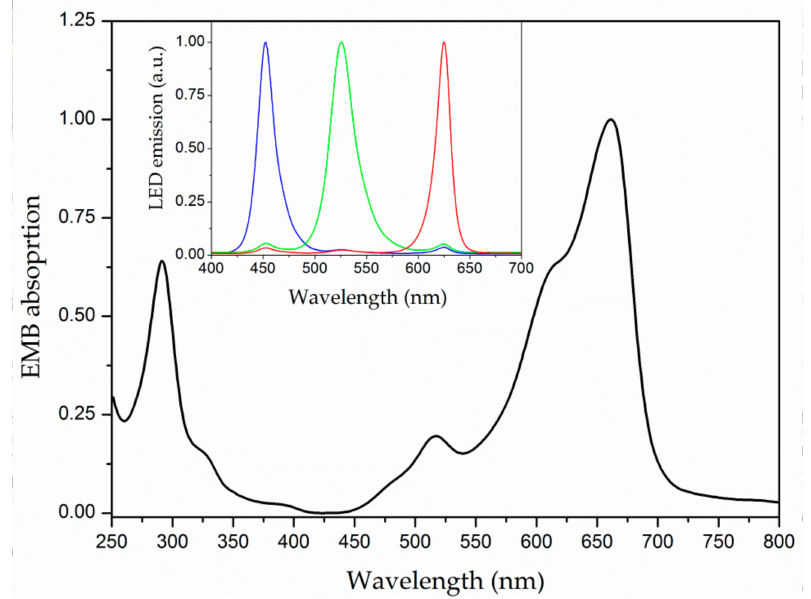
Figure 1. Normalized absorption spectrum of eosin-methylene blue (EMB) diluted in distilled water. Inset: RGB LED emission